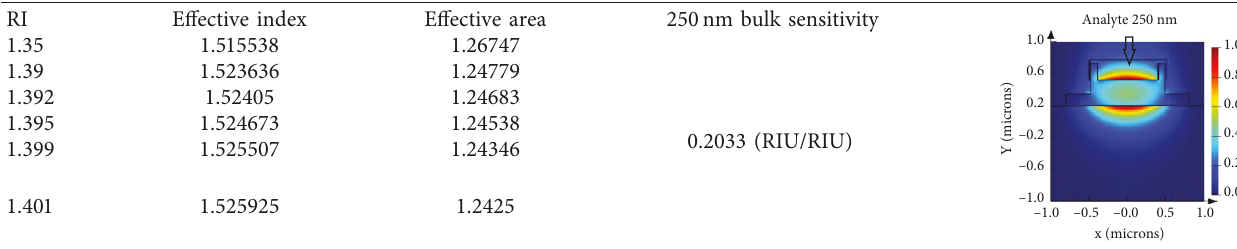
Table 4: Analysis of bulk sensitivity of rib-slot waveguide with 250nm analyte thickness.